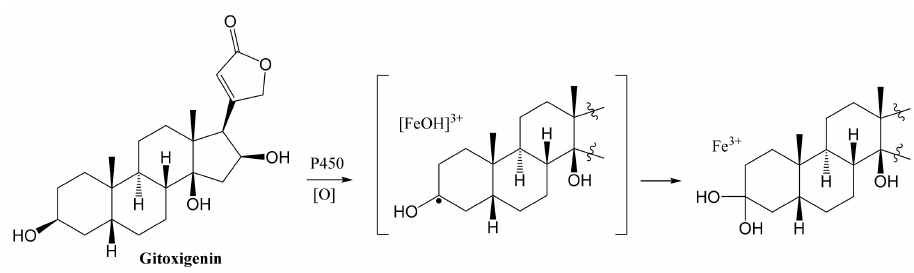
Figure 6. A plausible path for the formation of acetal group in 4